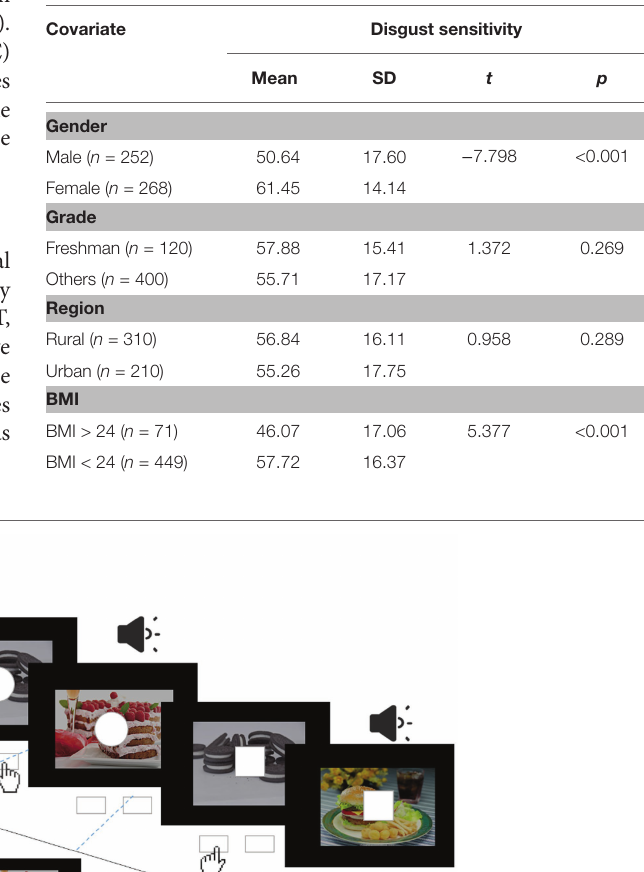
TABLE 1 | Differences between groups in the sample in disgust